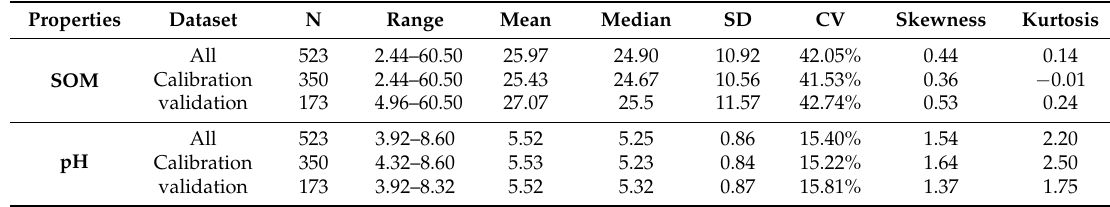
Table 2. Statistics describing organic matter content (SOM, g/kg) and pH measured in the laboratory.